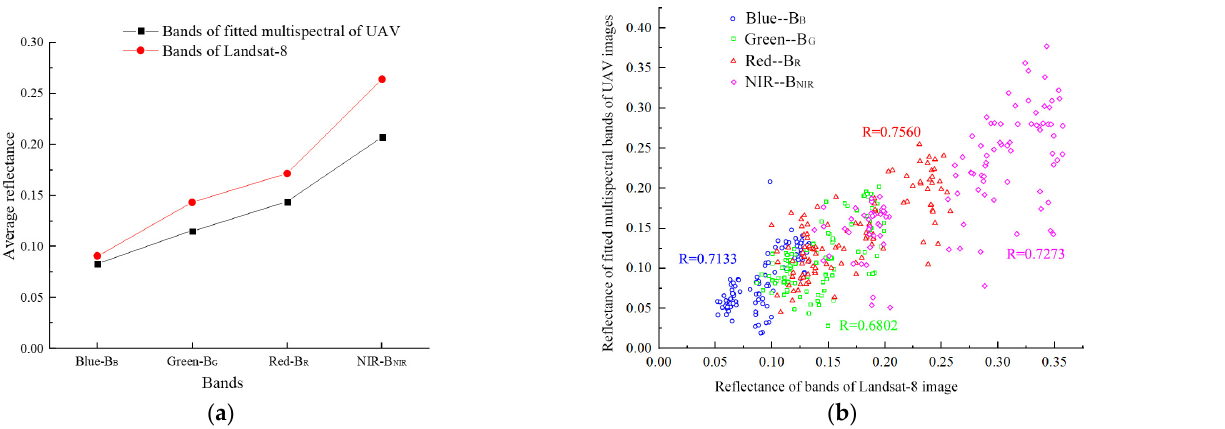
Figure 7. Comparison ( a ) and scatter plot ( b ) of surface reflectance of the fitted multispectral bands of the UAV images and bands of the Landsat-8 image. The reflectance correction coefficient of each band was calculated as the average re- flectance ratio of the Landsat-8 image to the fitted UAV images (Table 9). Then, the reflec- tance of four bands of the Landsat-8 images was divided by the correction coefficient of the corresponding band to obtain the corrected Landsat-8 image. Table 9. Reflectance correction coefficient of the Landsat-8 satellite image. Band